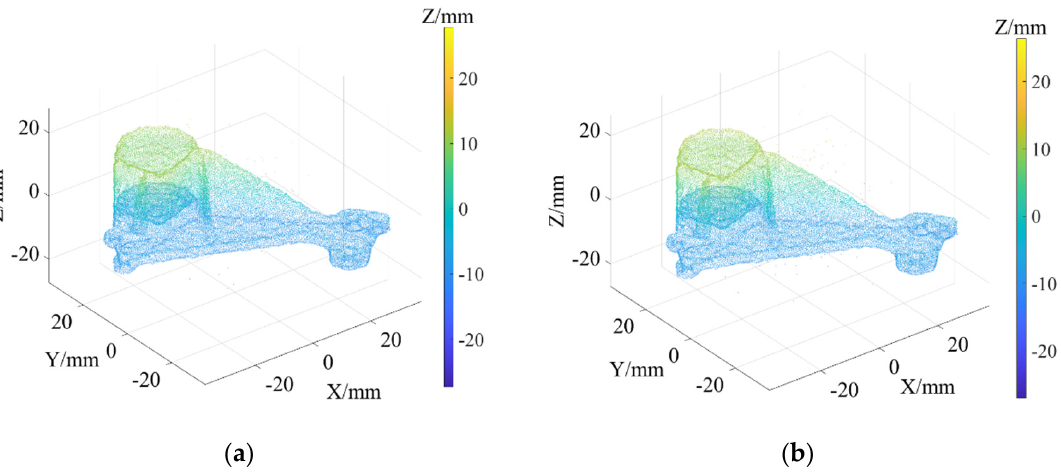
Figure 5. Denoising results of APSS under different noise intensities: ( a ) APSS (𝜎 = 0.2) ; ( b ) APSS (𝜎 = 0.4) .